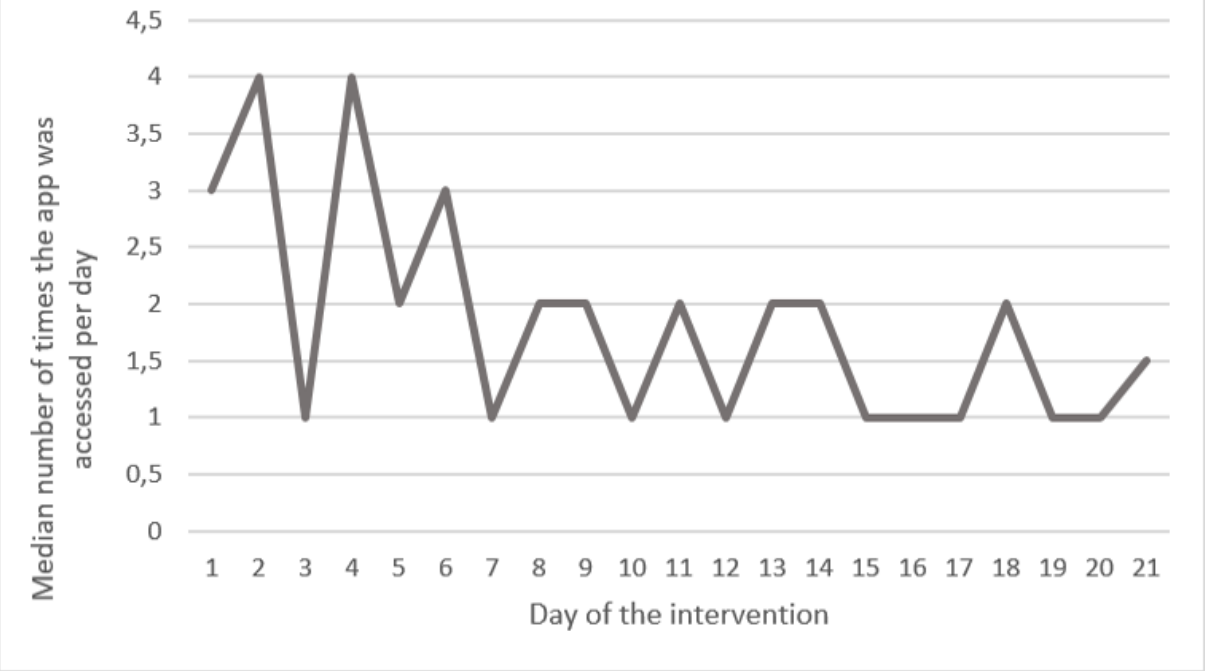
Figure 4. Evolution of consulting visual